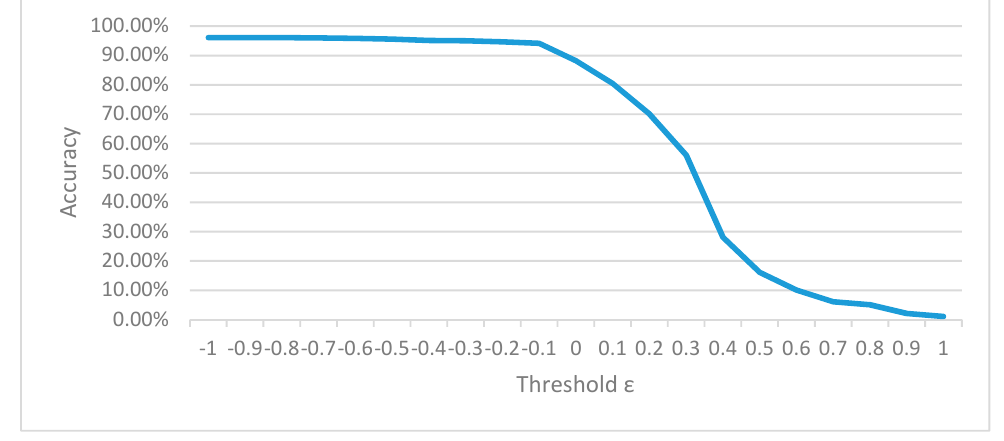
Figure 13. Classification accuracy changes with different threshold values.